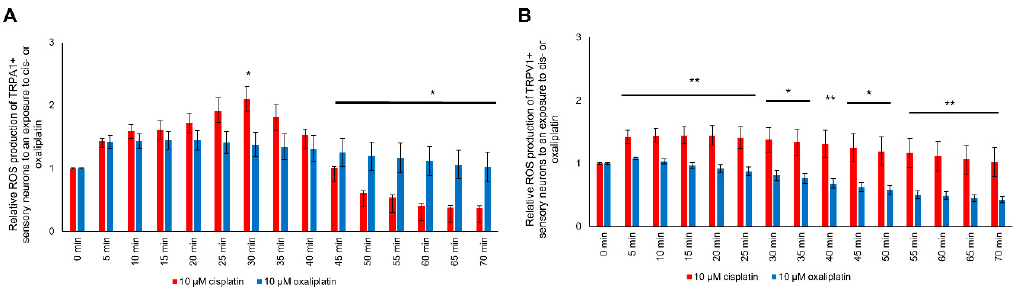
Figure 8. The ROS production of TRPA1- or TRPV1-positive DRG neurons during exposure to cis- or oxaliplatin. ( A ) A difference could be determined for TRPA1-positive DRG neurons at 30 min with a higher ROS production for cisplatin-exposed DRG neurons at 2.100 ± 0.197 (* p < 0.05). After 45 min (1.194 ± 0.223; * p < 0.05) until 70 min (1.022 ± 0.233; * p < 0.05), the ROS production was higher for oxaliplatin-exposed neurons. ( B ) The ROS production of TRPV1-positive DRG neurons was higher for cisplatin-exposed neurons over the entire experimental period (* p < 0.05, ** p < 0.01). n = 6 cells per condition. * = significant e ff ect compared to control